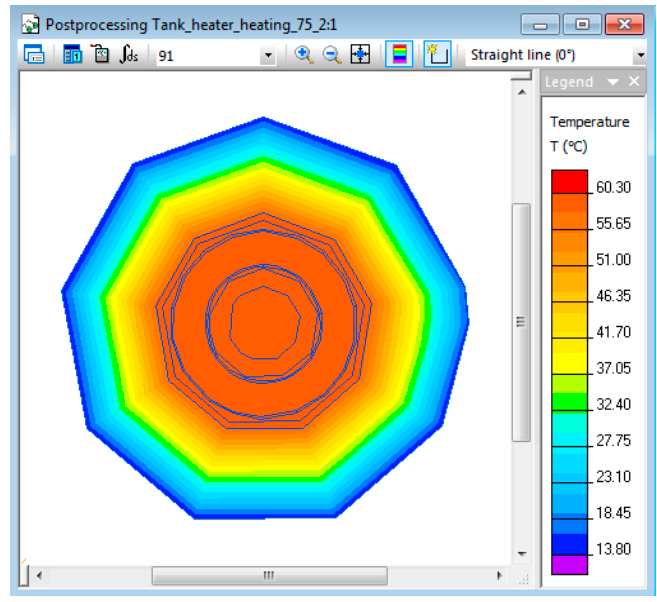
Figure 13. The AMD cooling temperature distribution for 1200 s.